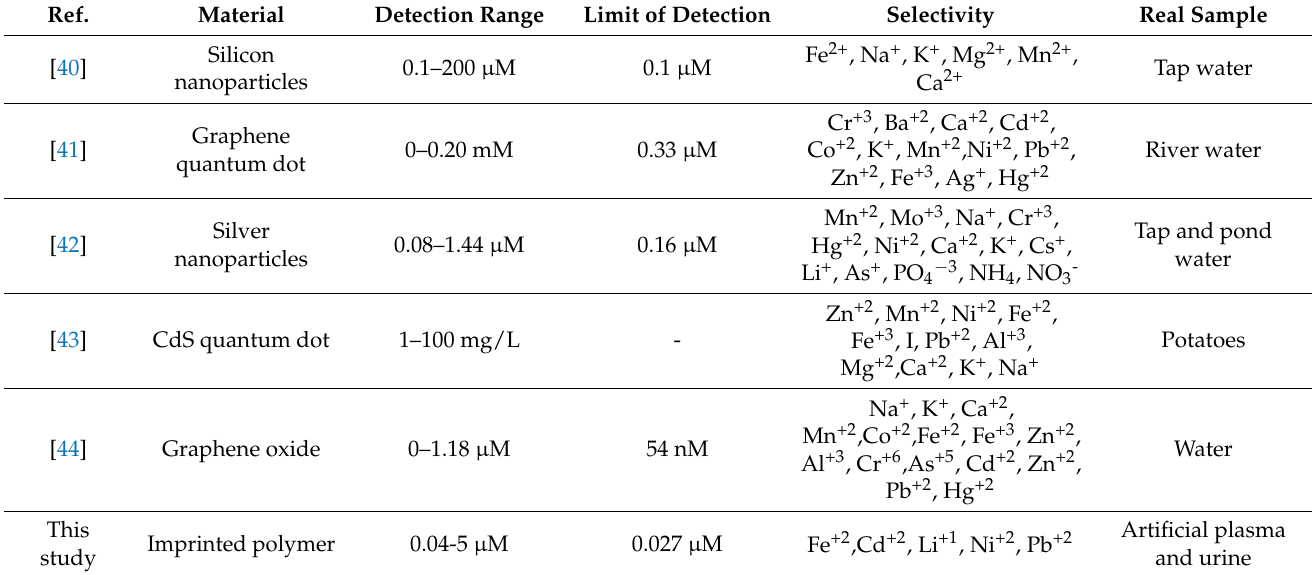
Table 1. Comparison of optic sensors for Cu(II) detection.